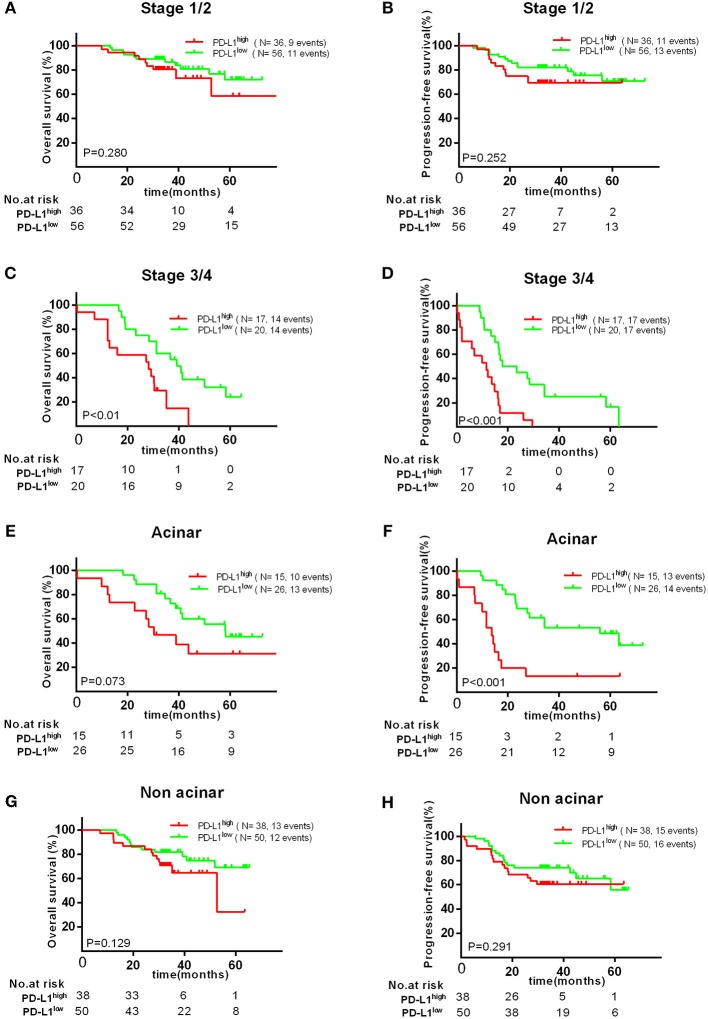
Kaplan–Meier curves showing OS (A,C,E,G) and PFS (B,D,F,H) of different subgroups (clinical stage I/II, III/IV, acinar, or non-acinar adenocarcinoma, respectively) with high and low expression of PD-L1.